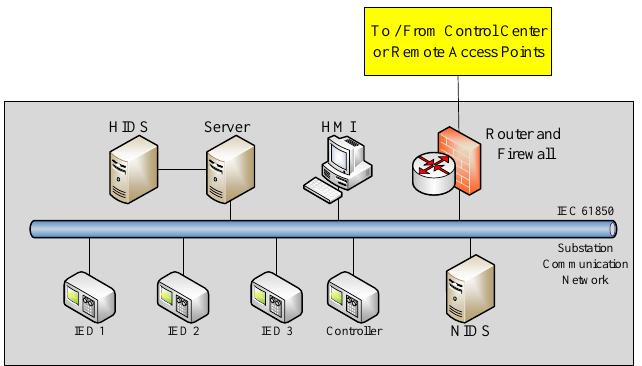
Figure 4. Architecture of an SCN with network-based IDS (NIDS) and host-based IDS (HIDS) installed.